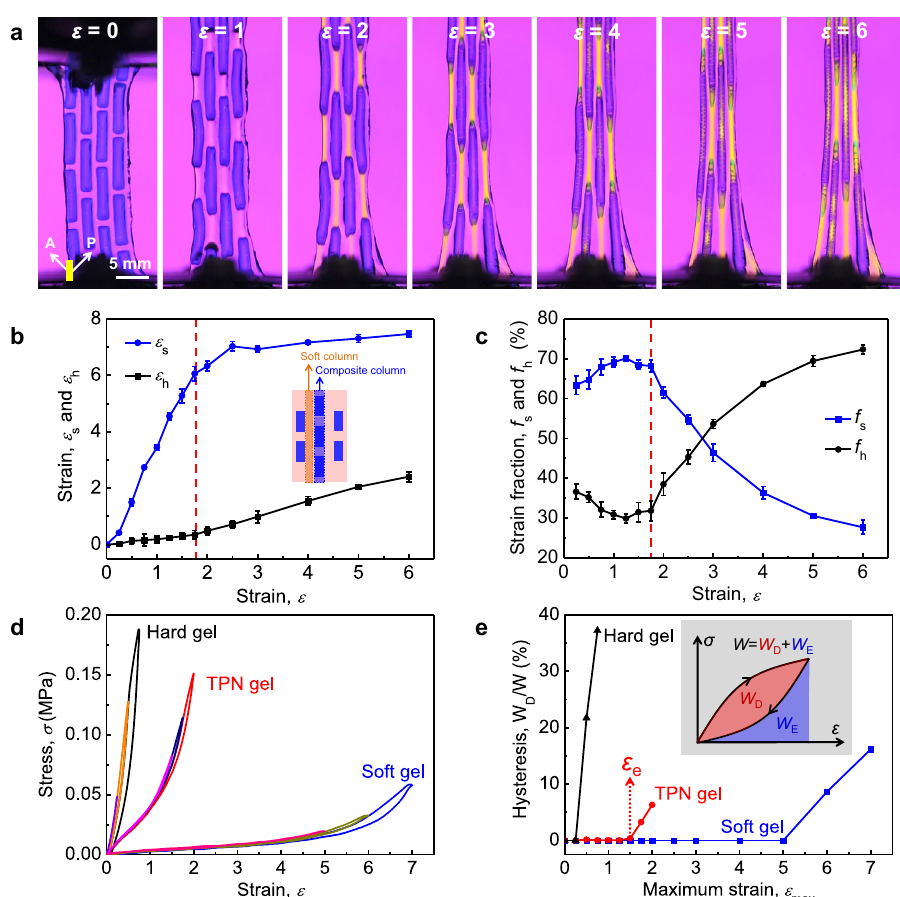
Fig. 2 Deformation of TPNs. a Deformation of a TPN observed using the crossed polarizer and analyzer. As the long-chain matrix deforms, the orientation- induced anisotropy of the refractive index causes the observed brightness. b The strain ε s and ε h of the soft and hard segments in a composite column plotted as functions of the applied strain ε . c Strain fraction f s and f h of the soft and hard segments. At least three samples were tested for the calculation of average value and standard deviation. d Load and unload stress – strain curves of soft, hard, and TPN gels with the increasing maximum strain. e Dependence of hysteresis on the maximum strain. The elastic limit strain ε e for the TPN gel is highlighted by a red dotted arrow. The inset indicates work of extension W , dissipated work W D , and elastic work W E . The ratio W D / W is a dimensionless measure of